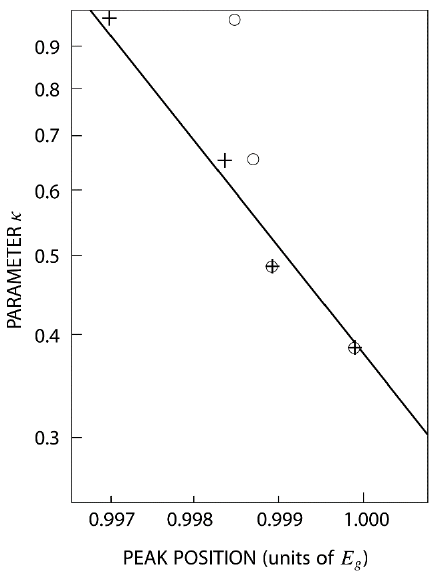
Figure 6. In the case of the experimental results, it is shown here the calculated peak position of the luminescence spectra of CdS as a function of the parameter κ: (o) including Coulomb correlation only, and (+) idem plus electron-phonon as described in the text. Parameter κ is the Fermi wavenumber multiplied by r spacing in units of the excitonic Bohr radius.